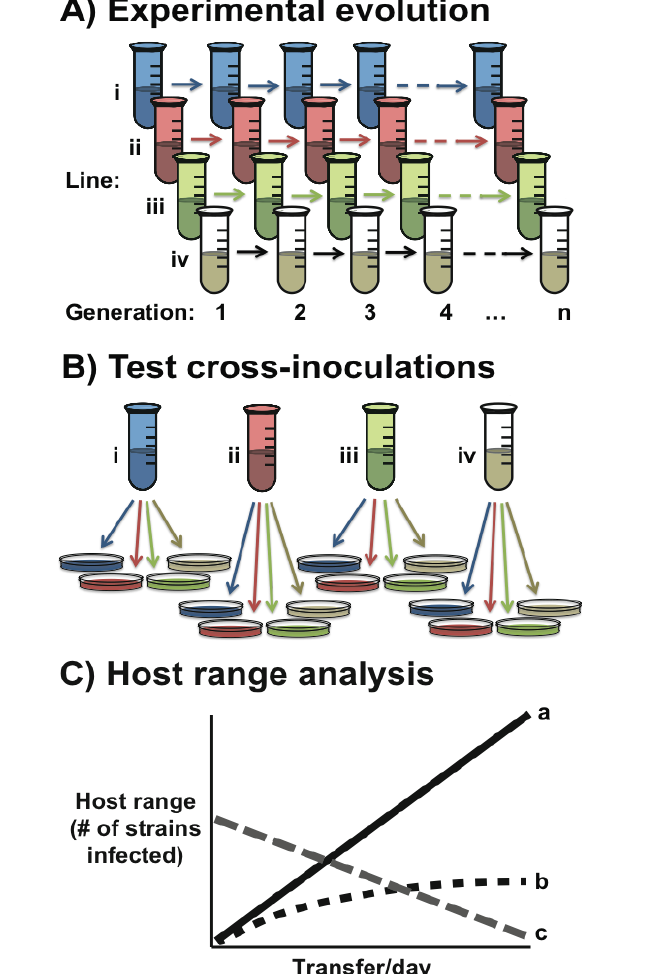
Figure 1. Illustrative example of experimental evolution of phage host range, where: ( A ) independent lines of genetically identical phage populations are propagated under different treatment regimens (e.g., different bacterial host species); and then ( B ) tested for infectivity on focal and alternate hosts. ( C ) Outcomes of these experiments might be a directional change towards increased host range over time (a), an initially increasing but then stable host range, perhaps indicative of coevolutionary response by the host population (b), or a decrease in host range associated with antagonistic pleiotropy during specialization on the focal host